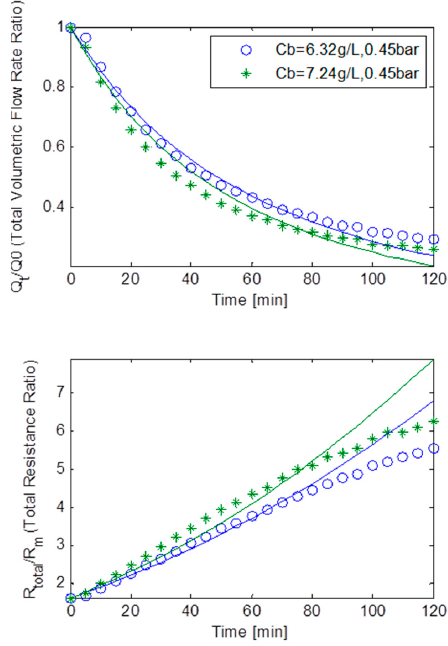
Figure 11. Flux decline and total resistance for TMP step of 45 kPa for the static square-shaped MBR system with best model fits.